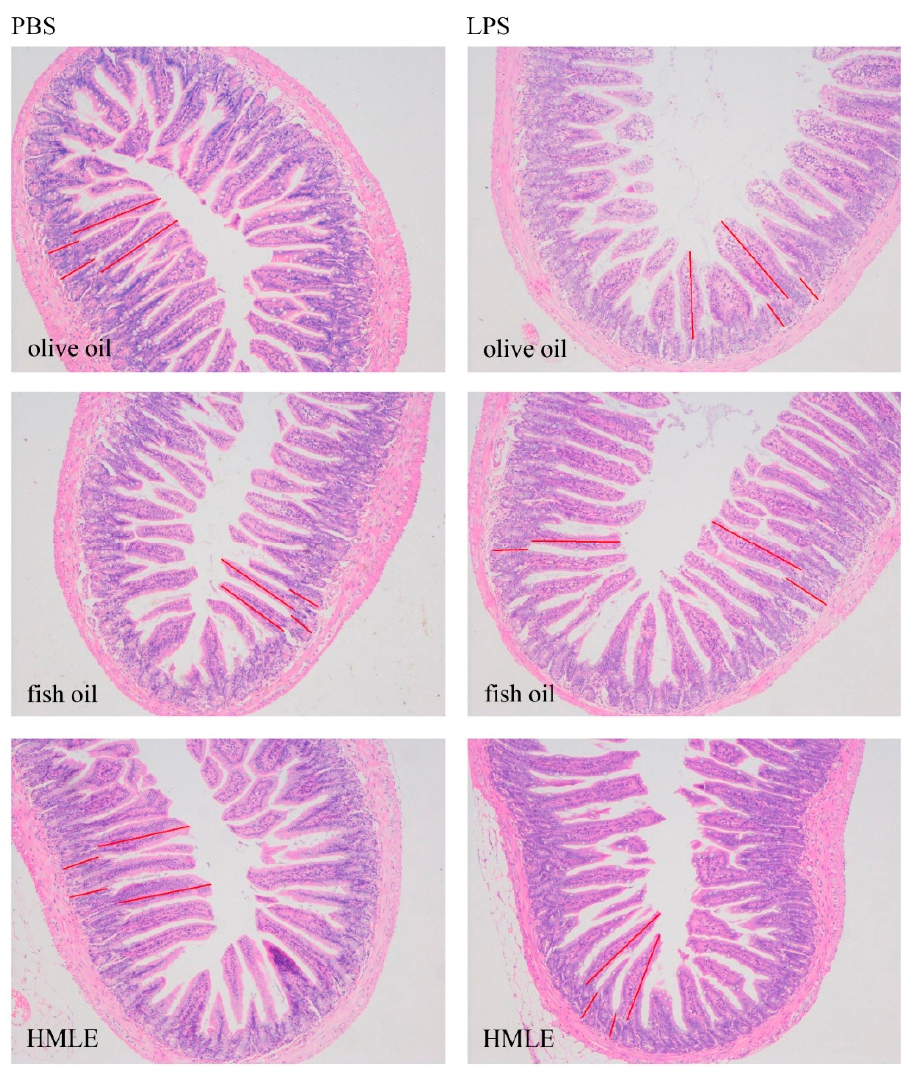
Figure 2. Changes in the body weight of mice. Data are represented as the mean ± SD.